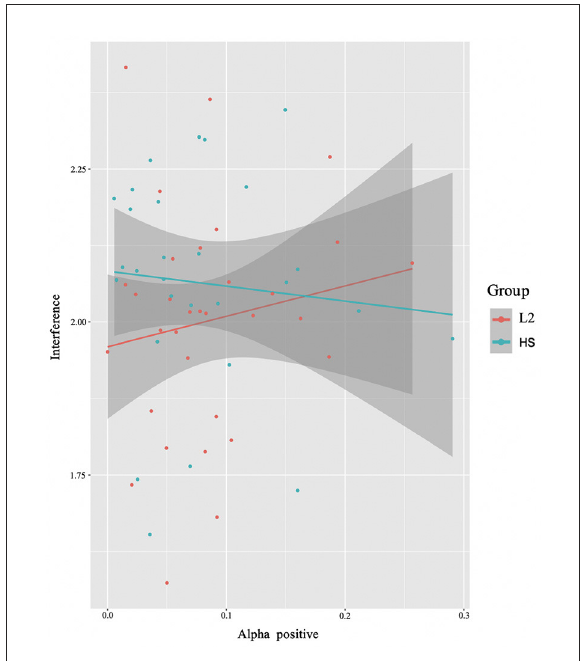
FIGURE7 Brain x behavioral analysis results. Interaction between alpha power (positive cluster) and group and interaction with behavioral RTs interference. The L2 learner group (L2) is represented in red and the HS group (HS) in green (see Section Identifying time-frequency clusters of interest for clusters of